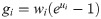
Comparison between the utility criterion and quantitative criterion.(a, b, c) The relationship between the gain and current wealth under the utility criterion (case 1, when u1 = u2 = 1). (d, e, f) The relationship between the utility and current wealth under the quantitative criterion (case 3). (a) The gain versus utility for both players, such that gi=wi(eui−1). Δg indicates the difference in g between the two players. (b) The difference in gain Δg (= |g1 –g2|) versus the difference in current wealth Δw (= |w1 –w2|). (c) Phase plane of Δg against w1 and w2. The dashed line indicate Δg = 0. (d) The utility versus both players’ gain, such that ut = log{(gt + wt)/wt}. Δu indicates the difference in u between the two players. (e) The difference in utility Δu (= |u1 –u2|) versus the difference in growth rate Δr (= r1/r2). (f) Phase plane of Δu versus w1 and w2. The dashed line indicates Δu = 0.